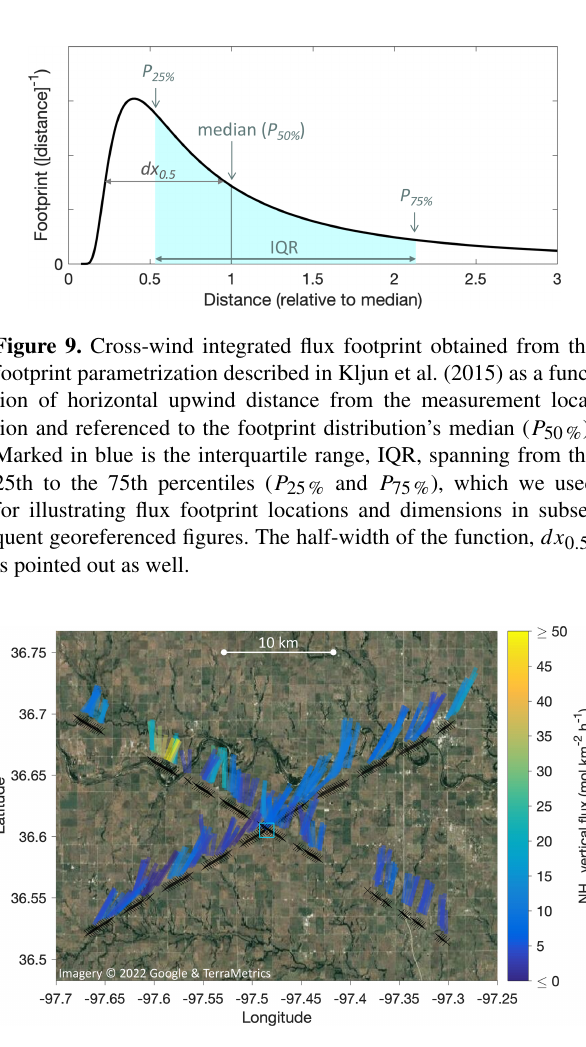
Figure 10. Map of the flux footprint estimates for the two low-level legs of RF13, flown at 310–320m above the SGP ground site eleva- tion (location marked by blue square). Black crosses mark flux mea- surement (i.e., aircraft) locations at 0.5Hz resolution, converting to a spacing of 180–195m. For each cross, a colored stripe marks the location of the interquartile range (IQR) of the respective flux foot- print distribution (cf. Fig. 9), assuming locations directly upwind. That is, winds were northeasterly. Stripe widths were chosen for visibility; stripe colors correspond to the magnitude of the measured EC fluxes ( F CWT